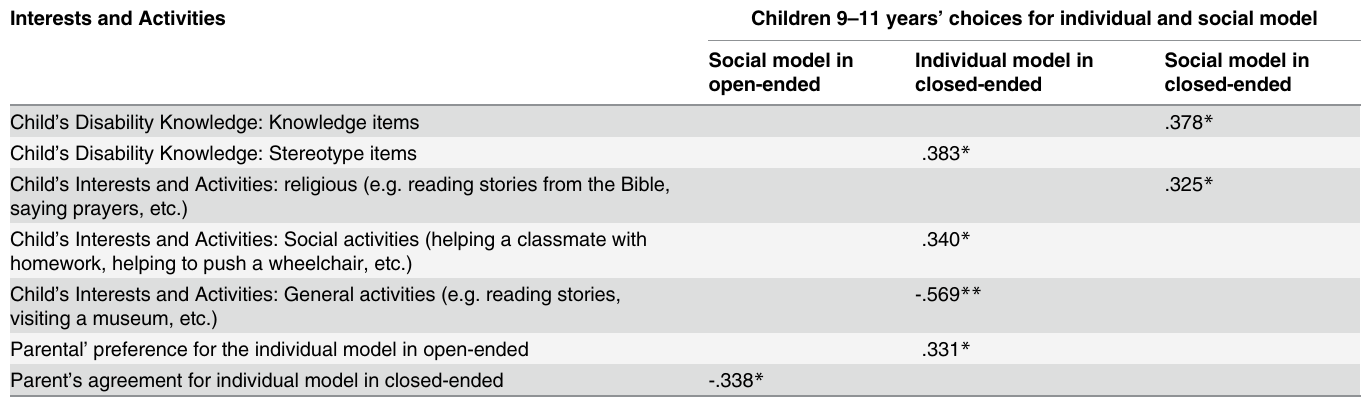
Table 2. Correlation between children 9 – 11 years ’ custom complex and their disability model